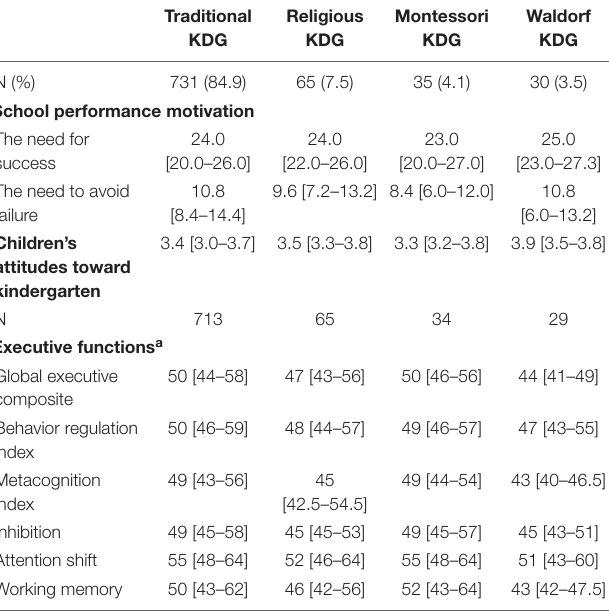
TABLE 2 | Description of the dependent variables in the individual types of